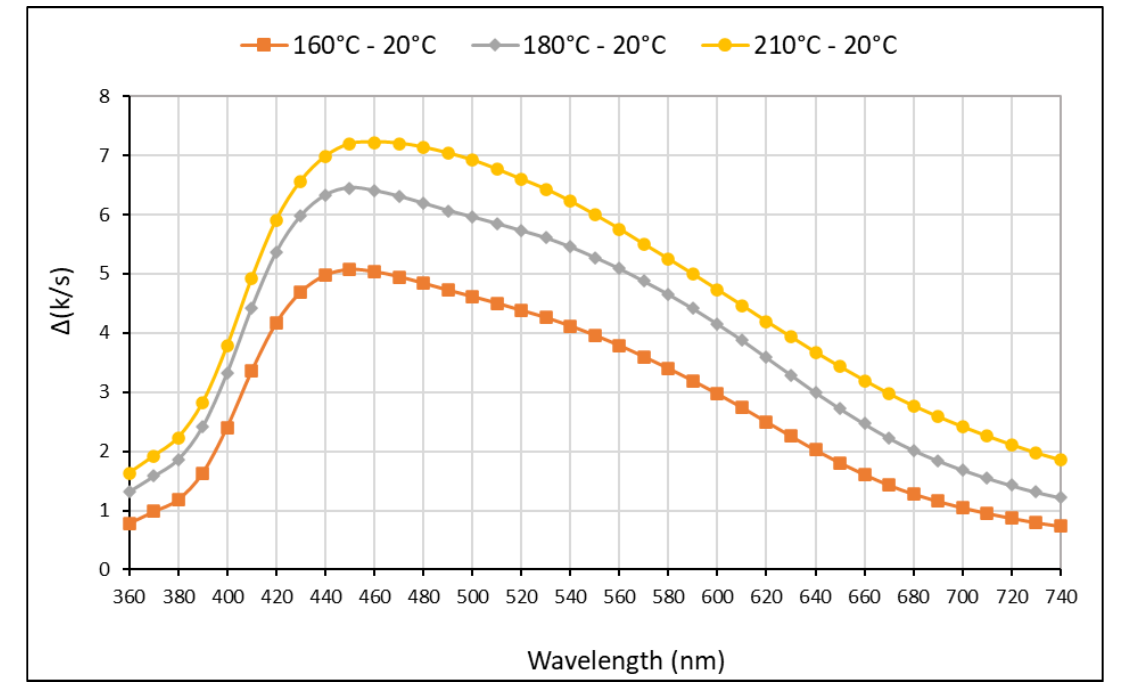
Figure 4. Absorption difference spectra Δ(k/s) of heat-treated black locust wood.